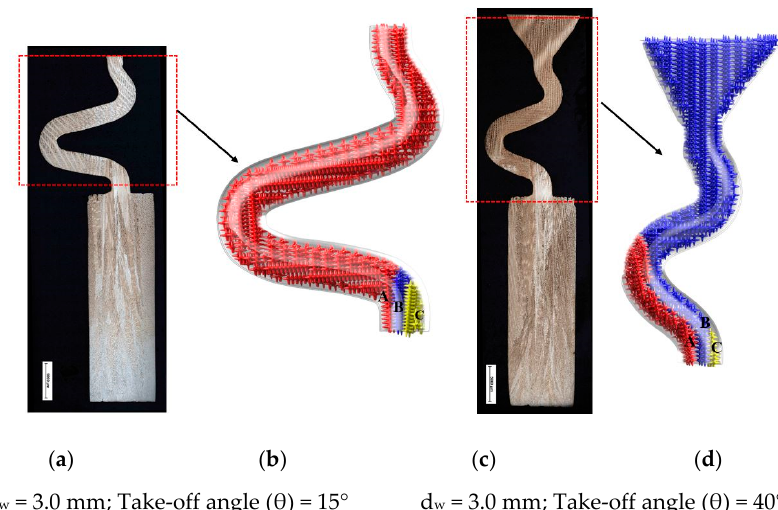
Figure 8. Optical images of the dendrite structure in the selector portion of the selectors with take-off angles of 15° ( a , b ) and 40° ( c , d ) as well as their corresponding schematic diagrams.